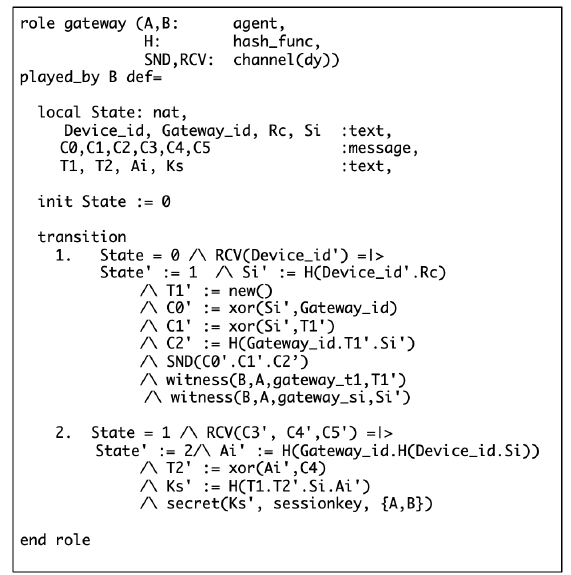
Figure 8. Specification of the HGW role for low security